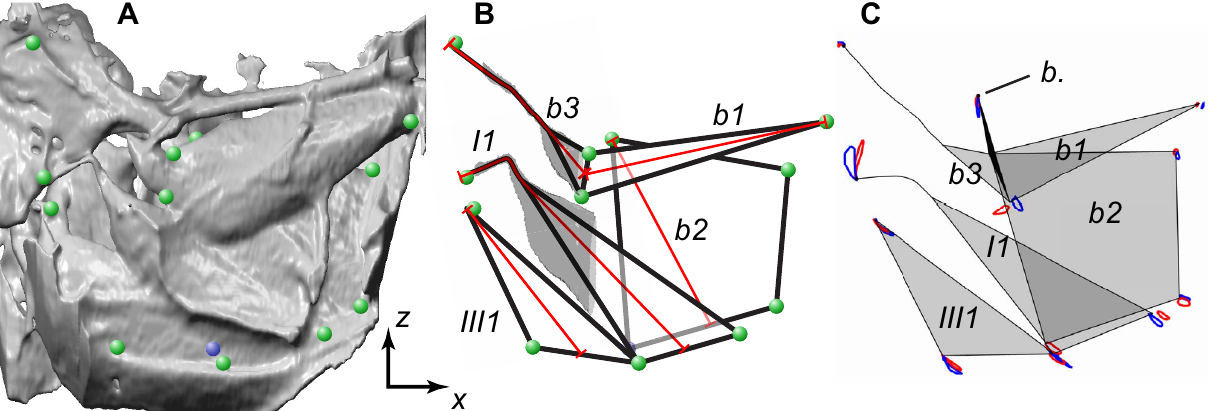
Figure 5. Measurements of muscle strains. (A) Three-dimensional surface rendering showing the internal view of the left steering muscles (high- amplitude wing). The steering muscles are viewed from the inside of the thorax looking out toward the wing hinge. The green circles indicate the endpoints of the muscles that were tracked. The blue circle shows the ventral base of b2 , which is hidden from view behind the I1 and III1 muscles. A clipping plane was used to remove these muscles so that the base of b2 was visible and could be tracked. (B) Schematic showing approximate shape of the five steering muscles (black lines) and the lines along which the muscle lengths were calculated (red lines). The grey shaded regions of I1 and b3 show where 3D skeletonization was used to find the centre line of the tendons to take buckling into account. (C) Diagram showing the movements of the endpoints of the steering muscles for the high-amplitude (blue orbits) and low-amplitude (red orbits) wings, averaged across flies. The view shown here corresponds to that in (C), with data for the other wing mirrored about the sagittal plane and overlain. The schematic representations of the muscles (shaded grey) and tendons (black lines) indicate the mean posture of the muscles at the start of the downstroke. b ., basalare sclerite (filled black).